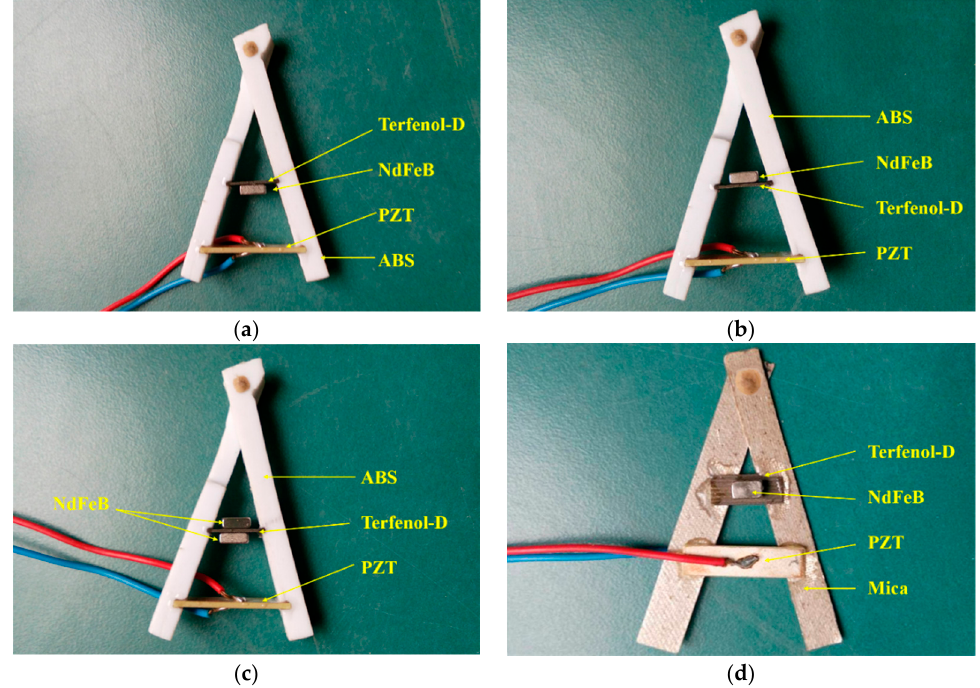
Figure 1. Photograph of the A-line shape Terfenol-D/PZT-5A structure with NdFeB magnets ( a ) ABS- case; ( b ) ABS+ case; ( c ) ABS+- case; ( d ) Mica case.